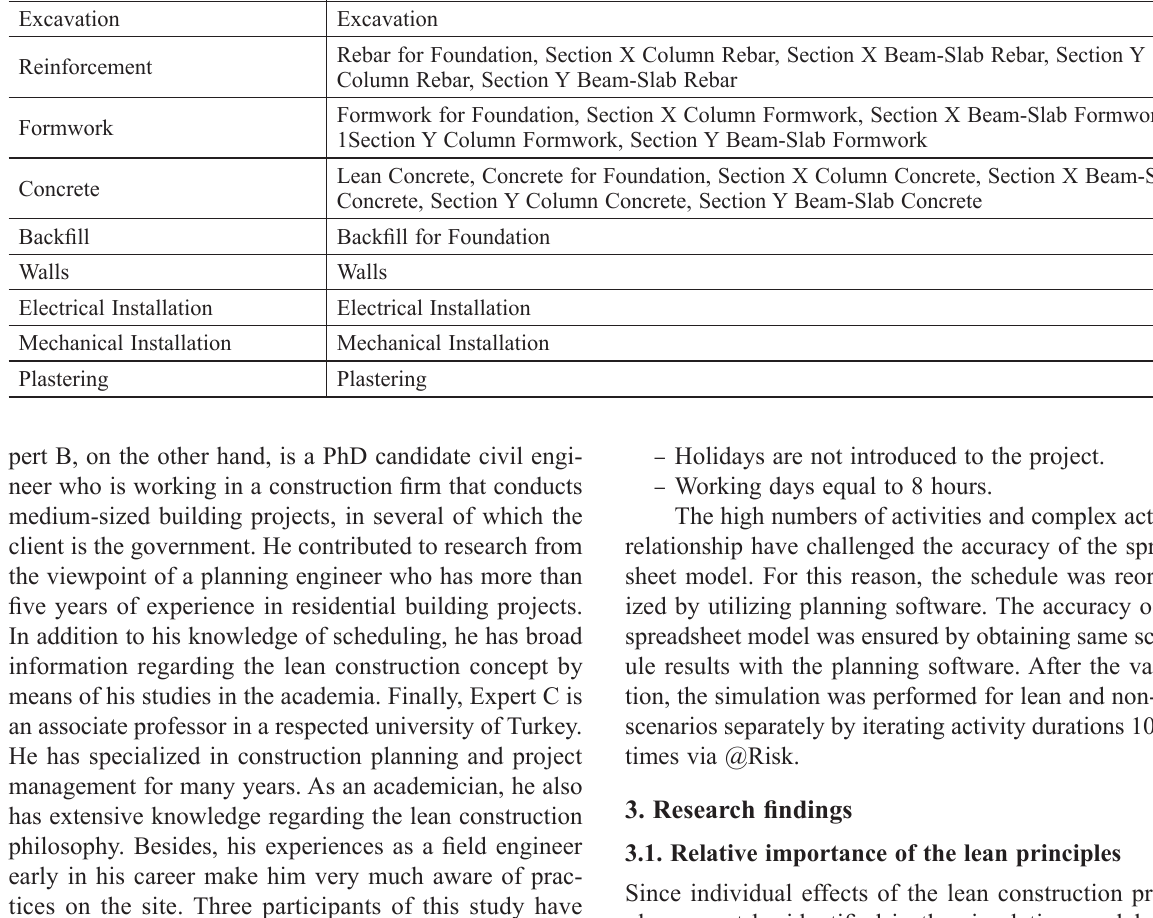
Table 4. Classification of the activities Basic activity group Related activity of the simulation